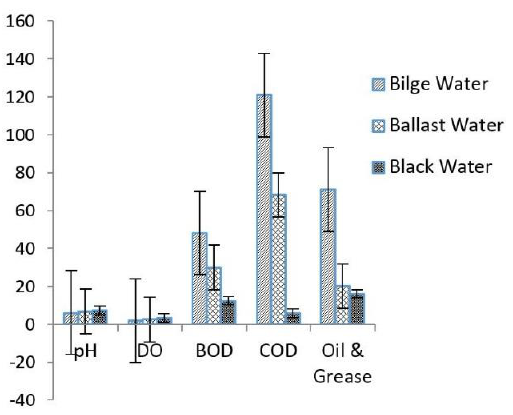
Figure 3. Distribution of the chemical parameters of shipborne wastewater.